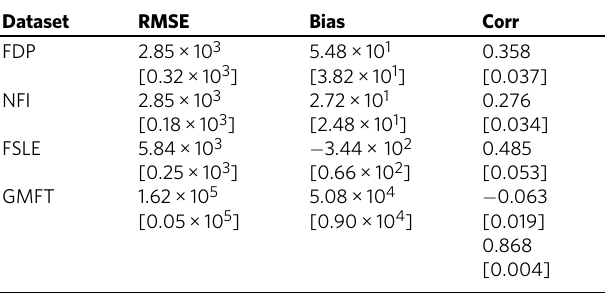
The performance of the fi tted model to predict individual density per 1km 2 natural forest was examined with four validation datasets (FDP, NFI, FSLE, and GMFT) and three benchmarks (RMSE, Bias, and Corr). The individual density of species was validated with FDP, NFI, and FSLE dataset,whereasthetotaldensityofwoodyplantswasvalidatedwithGMFTdataset.ForGMFT, in which individual density was validated at the scale of the 10-km grid cell, the correlation coef fi cient calculated based on individual density per grid cell is also shown in the second row. Standard errors are shown in brackets. Abbreviations: FDP – forest dynamics plots, NFI – National forest inventory, FSLE – forest sampling plots along latitudinal and elevational gradients, GMFT – global map of forest trees, RMSE – root mean square error of the model prediction for individual density, Bias – bias of the modelpredictionforindividualdensity, Corr – correlation coef fi cientof the logindividualdensity between model prediction and validation